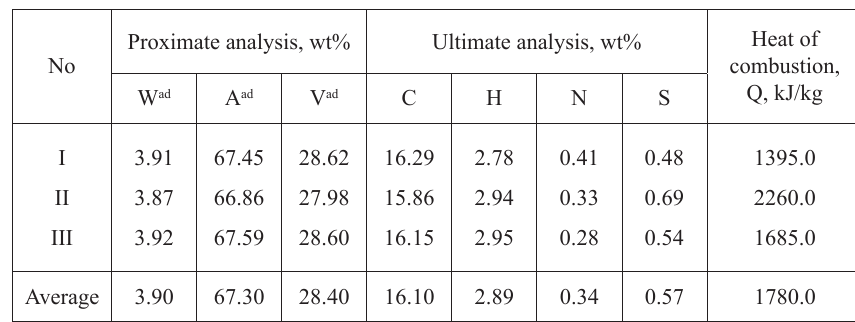
Table 2. Mineral composition of the ash of the studied oil shale sample, wt% SiO Al O Fe O MgO CaO K 2 2 3 2 3 40.36 8.12